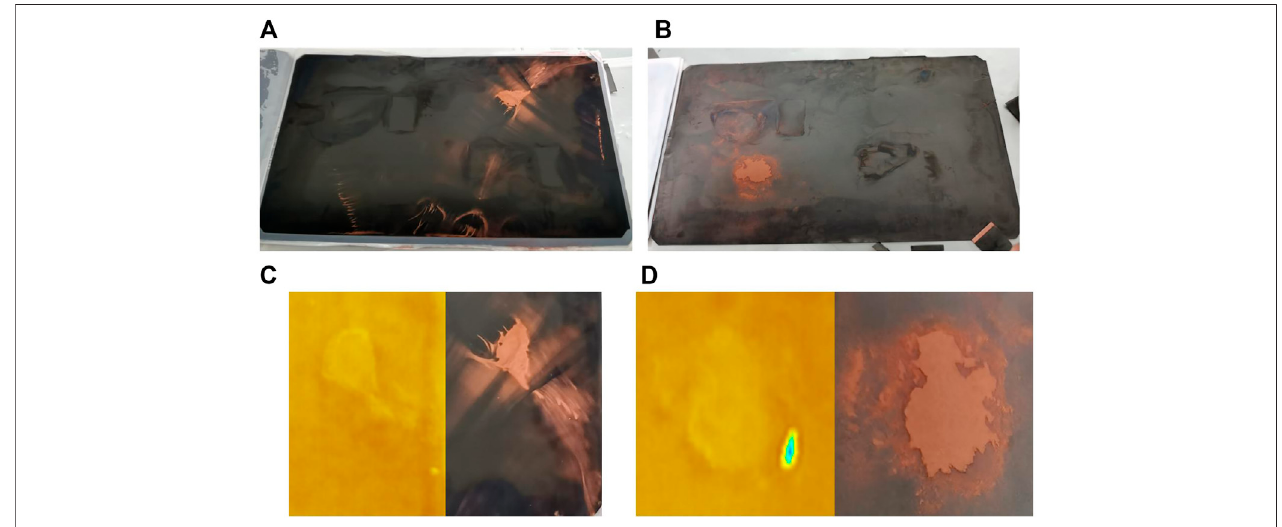
FIGURE 6 | The surface of the cathode (A) and anode (B) after disassembly. Partial enlargement comparison of Cu powder in transmission C-scan image and the remnants on electrode surface, (C) for cathode and (D) for anode.